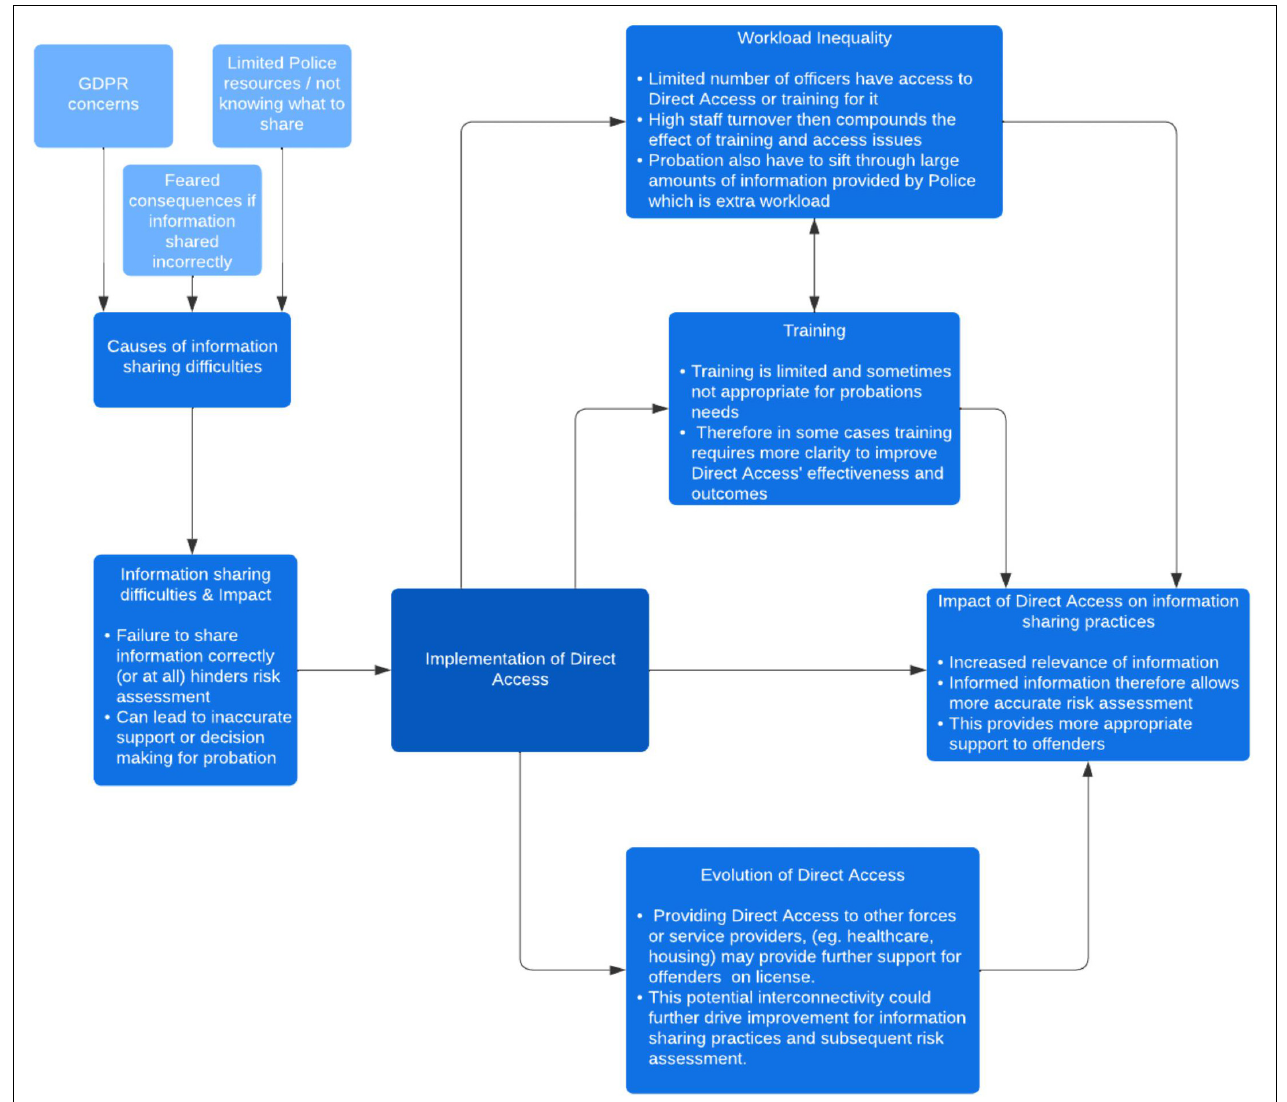
FIGURE 1 | Diagram of how themes relate to one